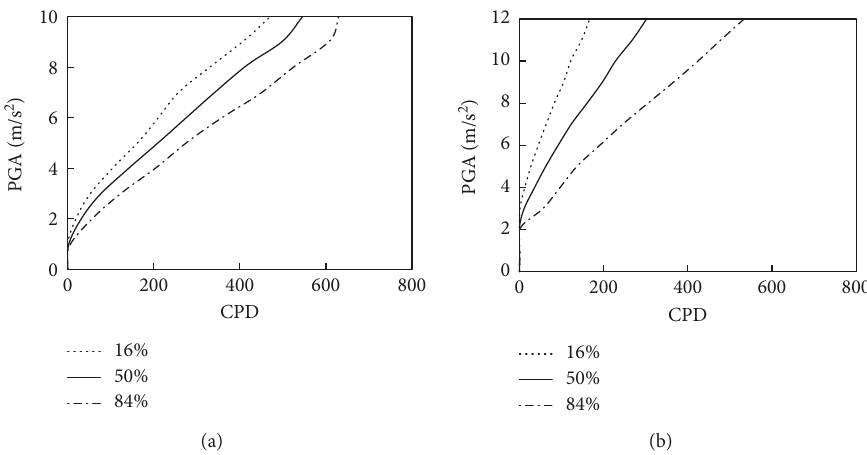
Figure 12: Distribution statistics of the BRB CPD: (a) response to near-fault ground motion; (b) response to far-fault ground motion.